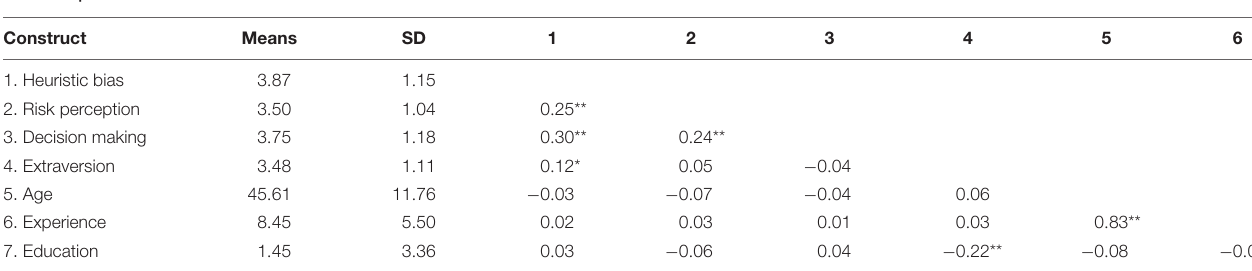
TABLE 1 | Means and correlations.